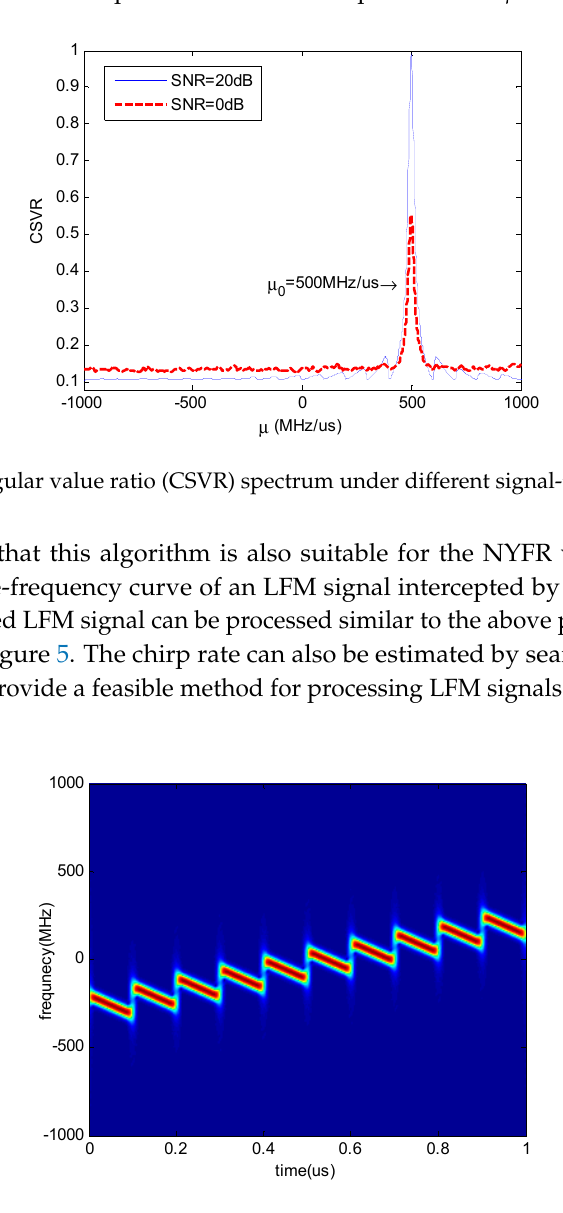
Figure 4. Time-frequency diagram of a sampled LFM signal using periodic LFM local oscillator (LOS).